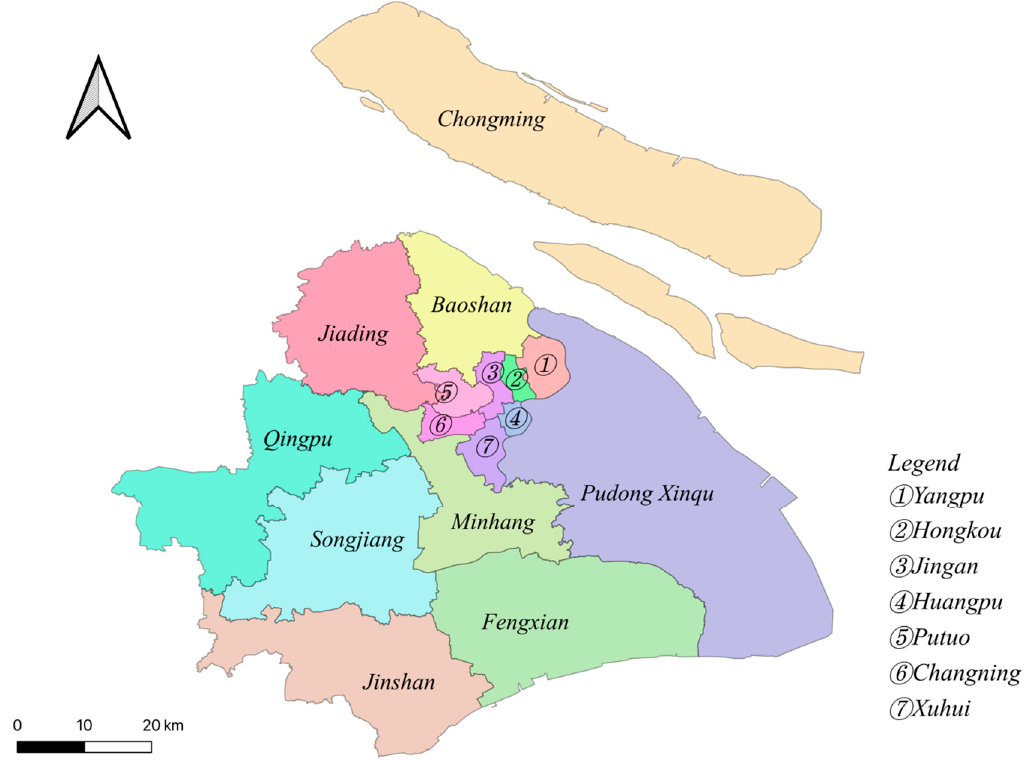
Figure 1. Locations of the 16 regions in Shanghai, China.